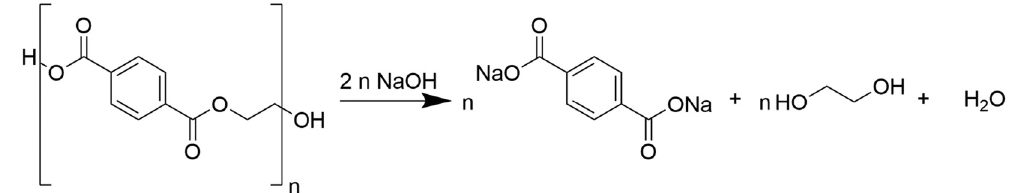
Figure 2: Reaction scheme of the PET